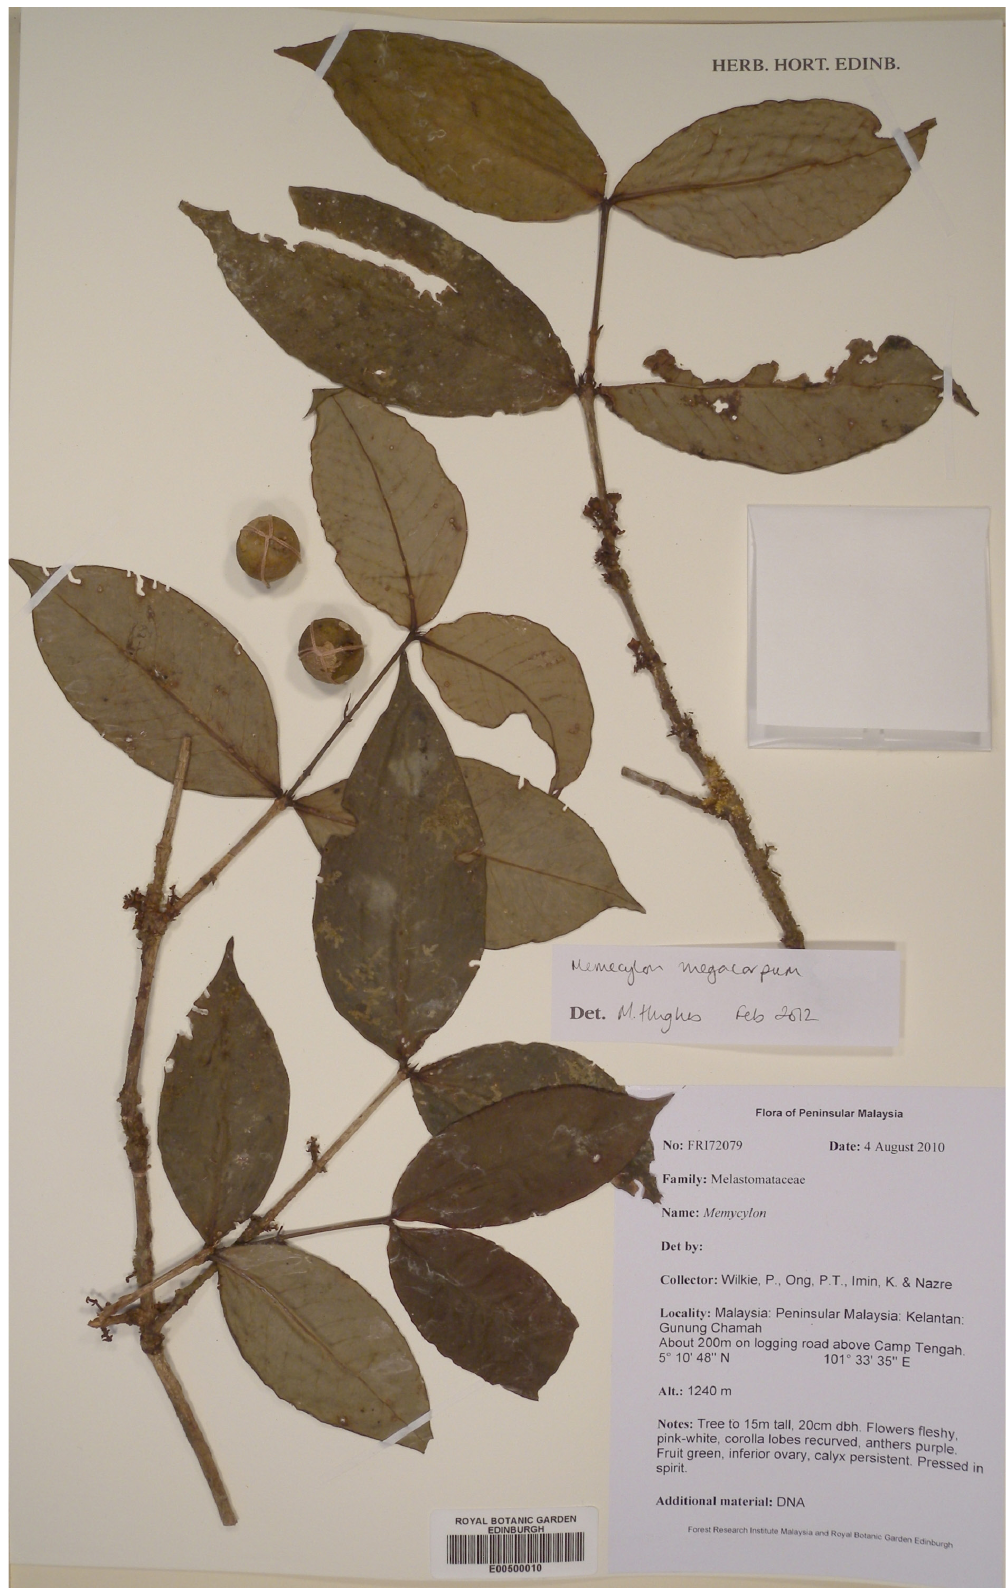
Fig. 2. Image of an isotype of Memecylon pseudomegacarpum sp. nov. [ Wilkie et al. FRI172079